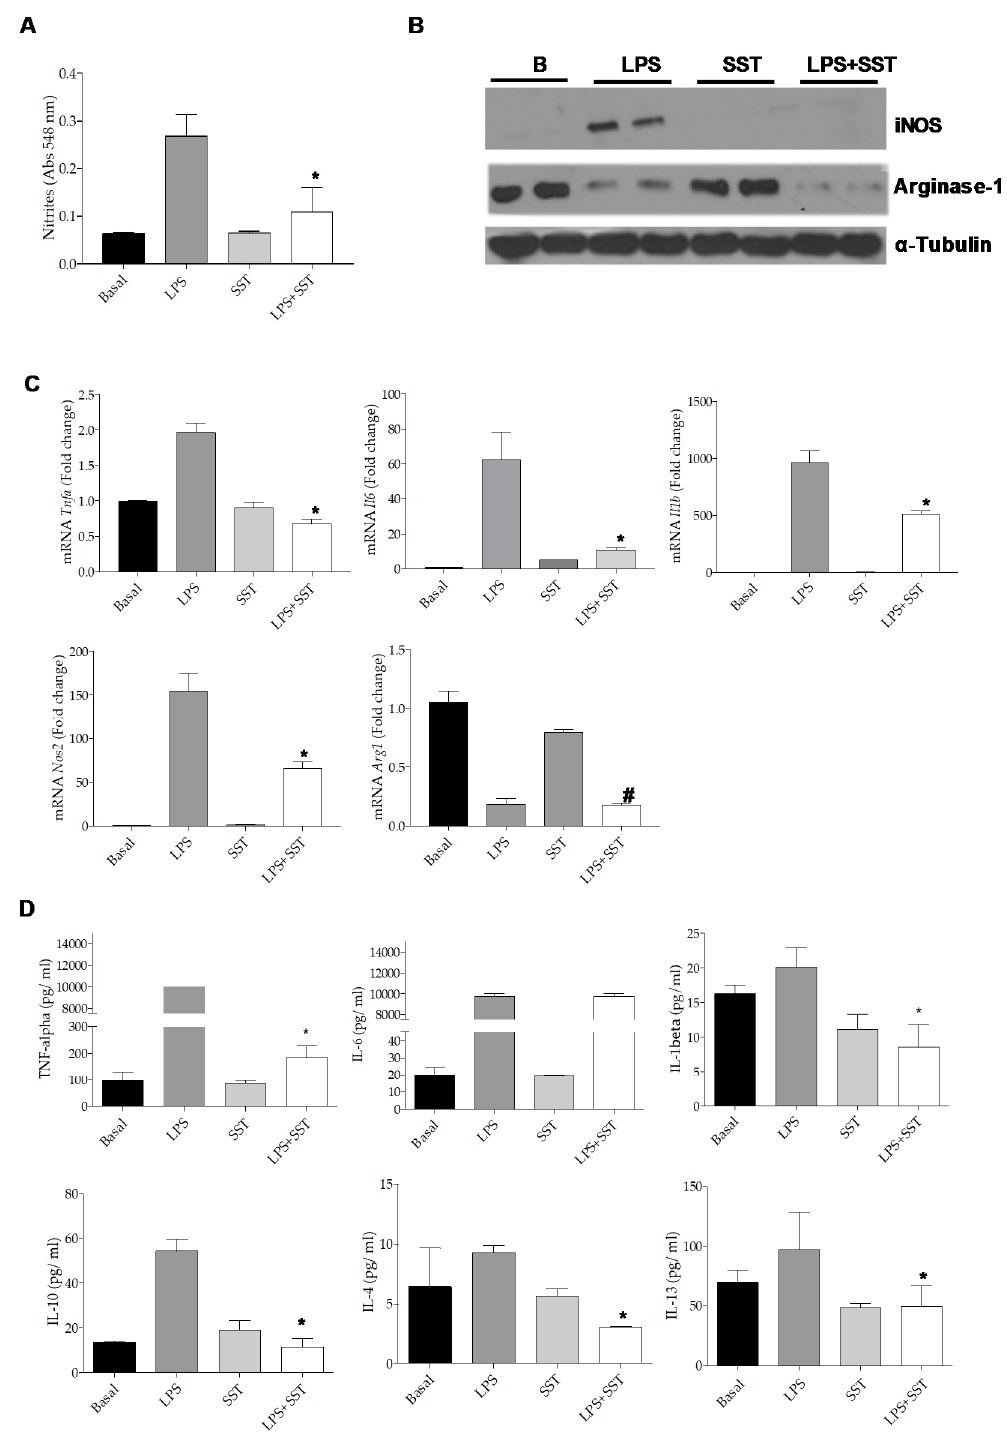
Figure 6. SST decreased inflammation in LPS-stimulated Bv.2 cells. Bv.2 microglial cells were pretreated with SST (10 -6 M) for 4 h and then stimulated or not with LPS (200 ng/mL) for a further 24 h. ( A ) Levels of nitrites in the culture medium were analyzed and referred to the basal (untreated condition) levels. Colorimetric quantification was performed and results are mean ± SEM. The fold of